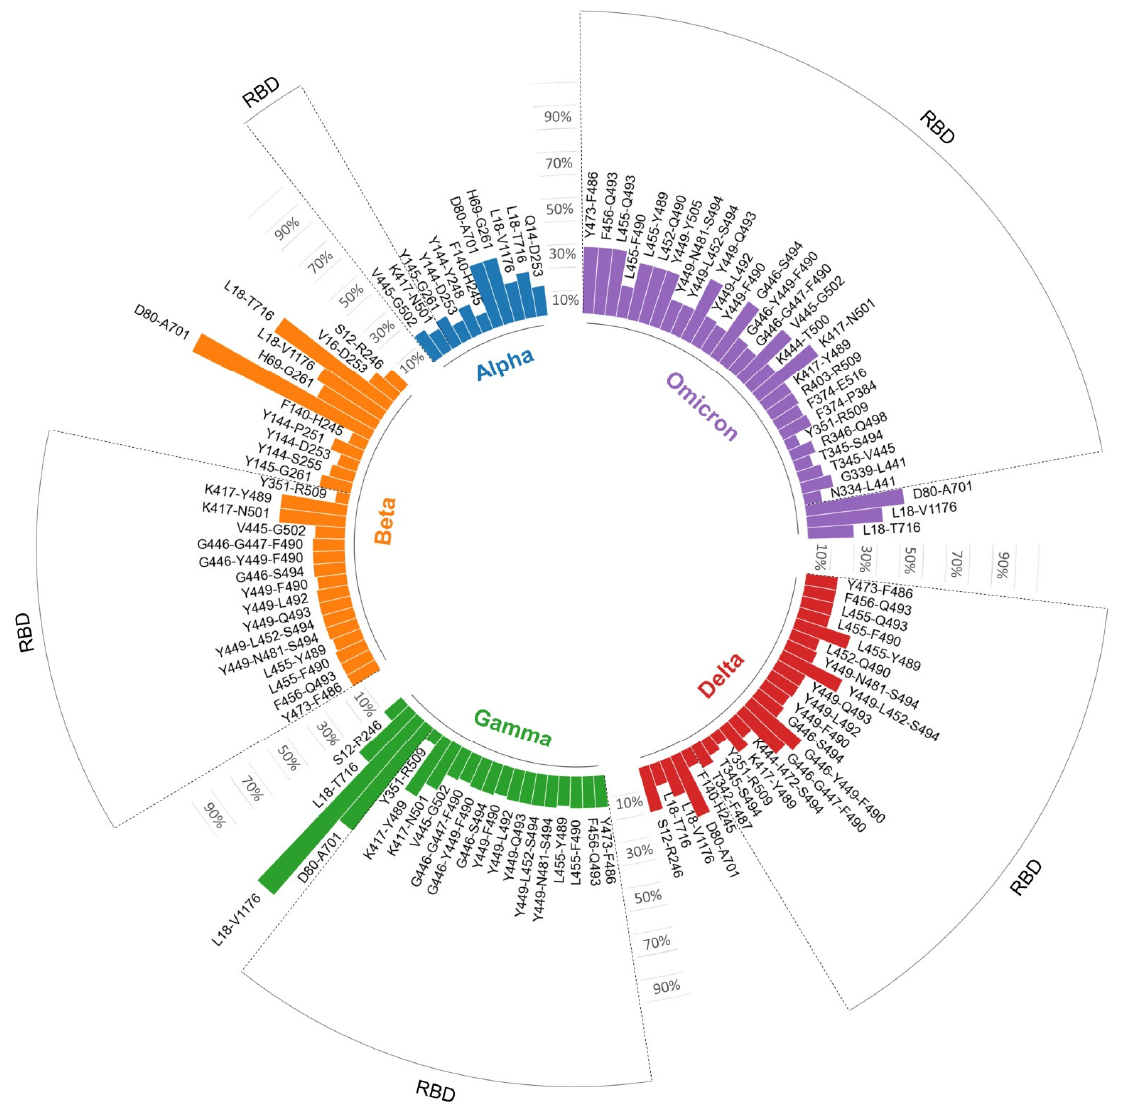
Figure 6. B cell epitope cores affected by mutations in SARS-CoV-2 variants. All 132 B cell epitopes targeted by neutralizing antibodies could be grouped in 54 clusters sharing seven or more residues (B cell epitope cores), and those mutated in each variant are indicated. The length of the bars is proportional to the percentage of mutated residues. Clusters within the receptor-binding domain (RBD) are framed. The residue composition of B cell epitope cores is provided in Table 3.